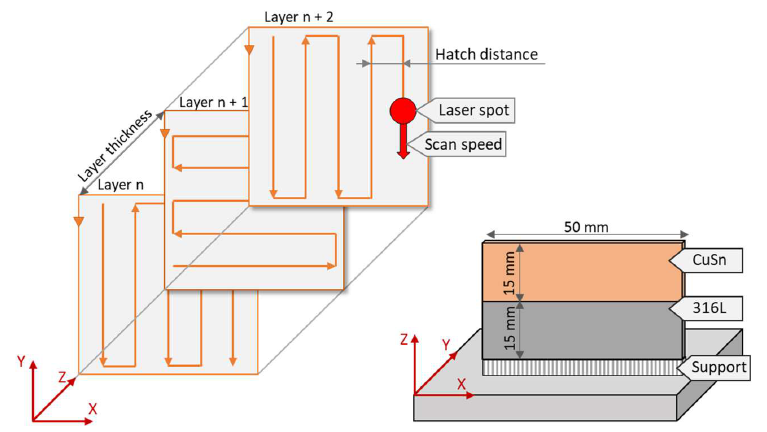
Figure 3. Schematic representation of hatching and path planning and the general fabrication of the multi-material.